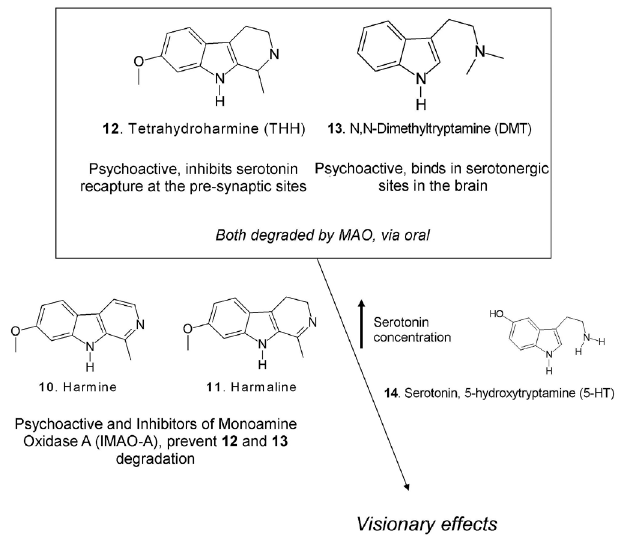
FIGURE 2 - Synergic mechanism of the psychoactive alkaloids found in the drink Hoasca.